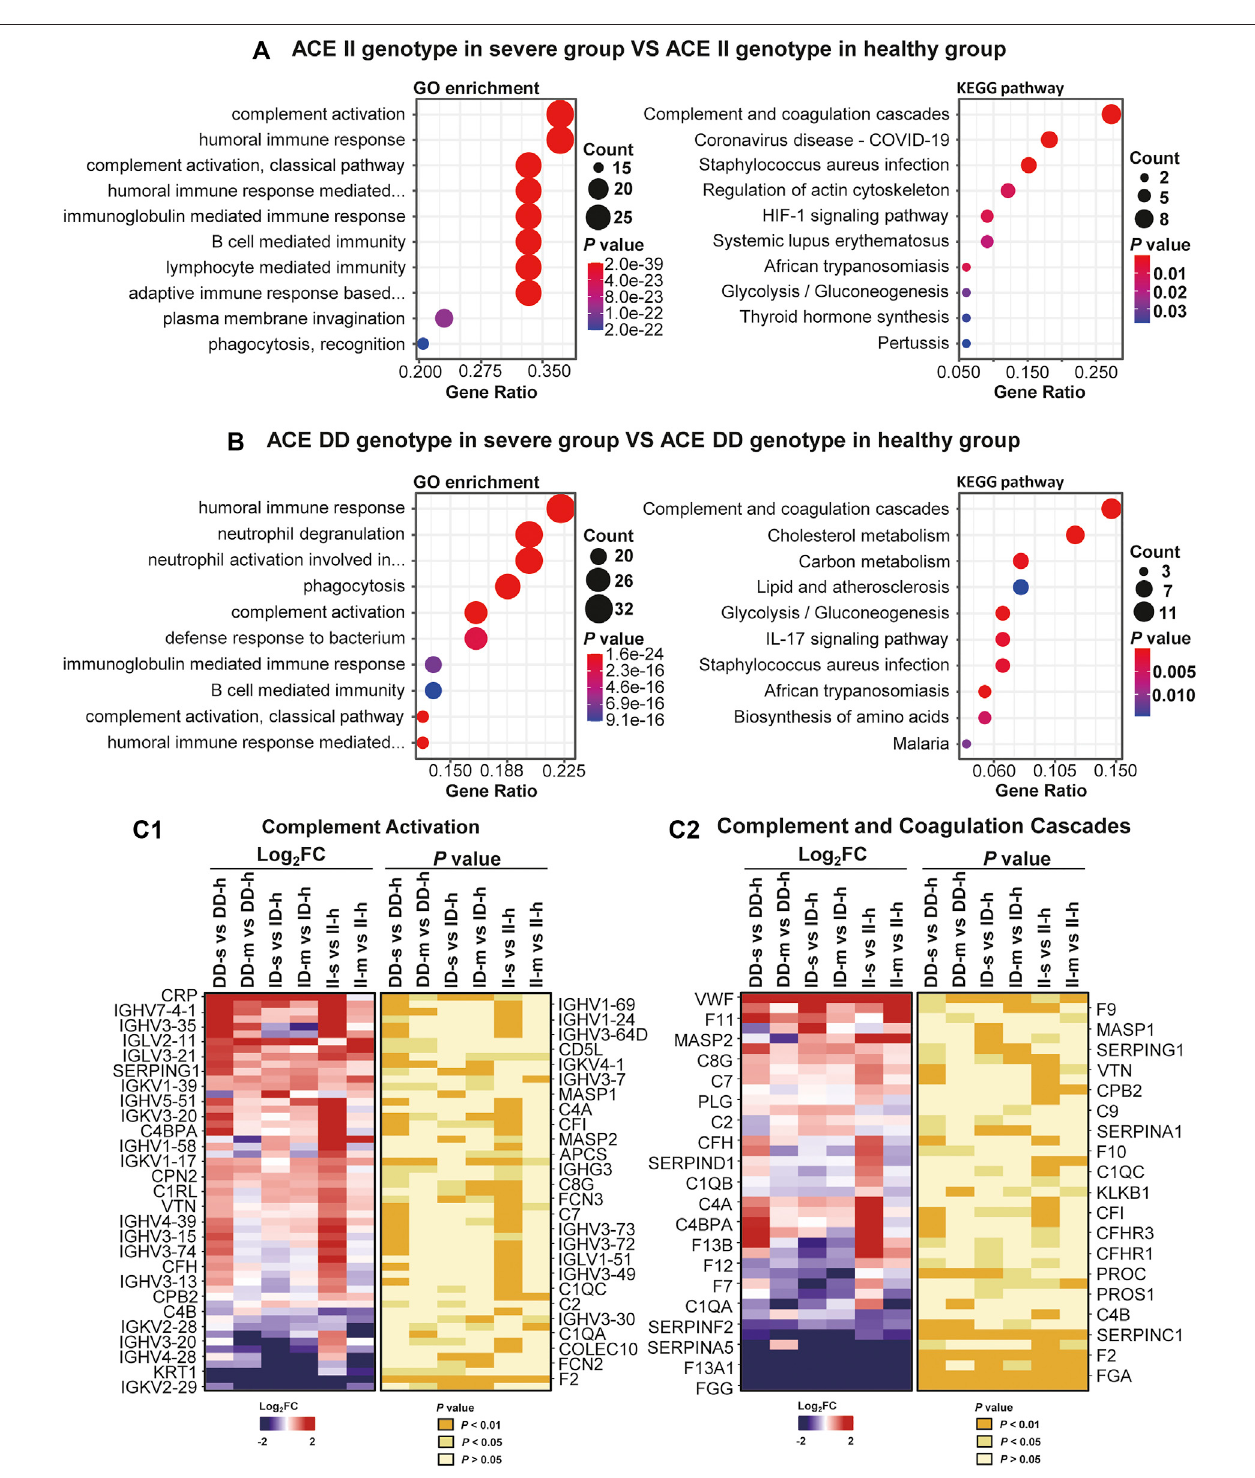
FIGURE 6| Differential expressions severe, mild, and healthy intergroups ofprospective research. (A) The ACE IIgenotype in the severe group vs ACE II genotype in the healthy group. (B) The ACE DD genotype in the severe group vs ACE DD genotype in the healthy group. GO enrichment analysis (left panel) and KEGG pathway analysis (right panel) of DEPs severe and healthy intergroups with the same genotype. GO analysis showed the top ten biological processes sorted by using the p value. KEGGanalysisshowedthetop10pathwayssortedby p value. (C1,C2) Theexpressionsofproteinsincomplementactivationbiologicalprocessandcomplement